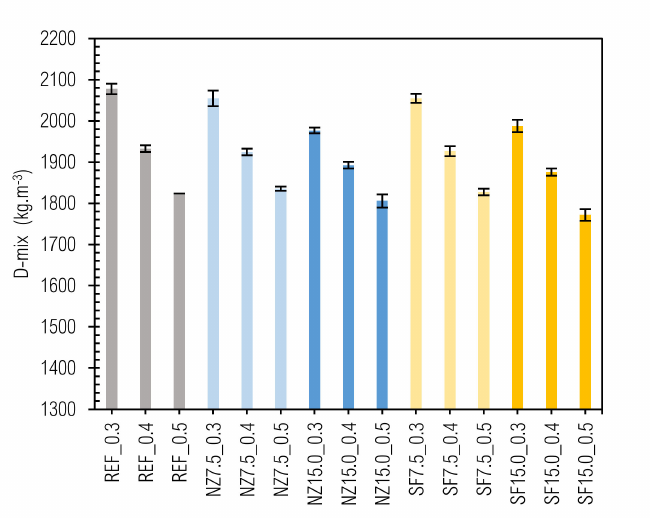
Figure 4. Fresh pastes’ density.